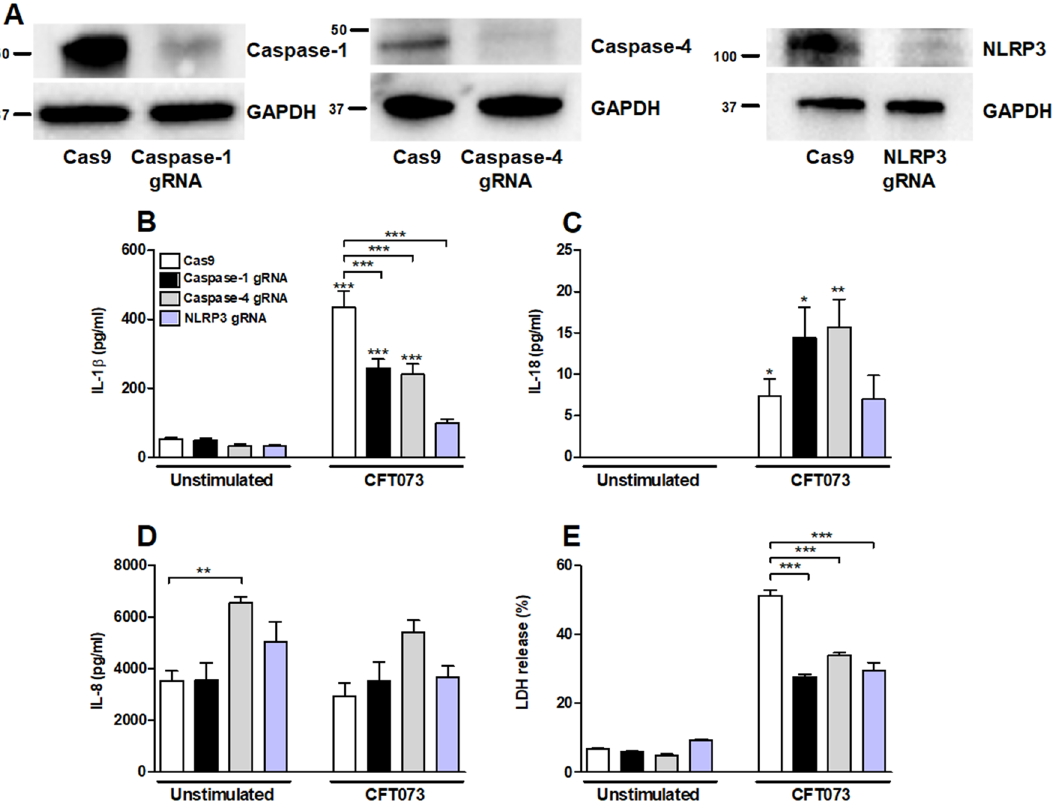
Figure 2. The knockdown of caspase-1, caspase-4 and NLRP3 in bladder epithelial cells using the CRISPR/ Cas9 system was assessed by Western blot analysis. GAPDH was used as loading control ( A ). Original western blot presented is available in Supplemental Fig. S1. IL-1β ( B ), IL-18 ( C ), IL-8 ( D ) and LDH ( E ) release from Cas9, caspase-1, caspase-4 or NLRP3-knockdown bladder epithelial cells after stimulation with UPEC strain CFT073 at MOI 10 for 6 h. gRNA stands for guideRNA targeting specific gene using CRISPR/Cas9. Data are presented as mean ± SEM of three independent experiments. Asterisks over error-bar show statistical significance compared to respective unstimulated control (* p < 0.05, ** p < 0.01, *** p <